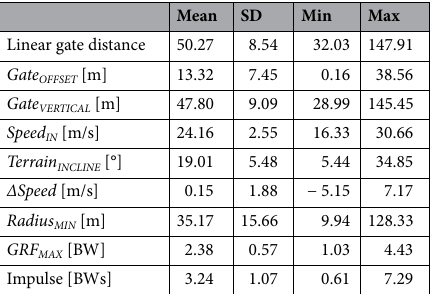
Absolute change in m required to reduce speed by 0.5 m/s